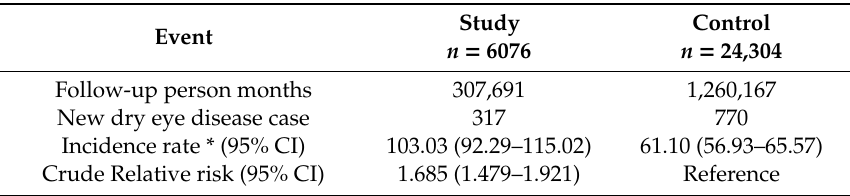
Table 2. Incidence rate of dry eye disease in the study group.